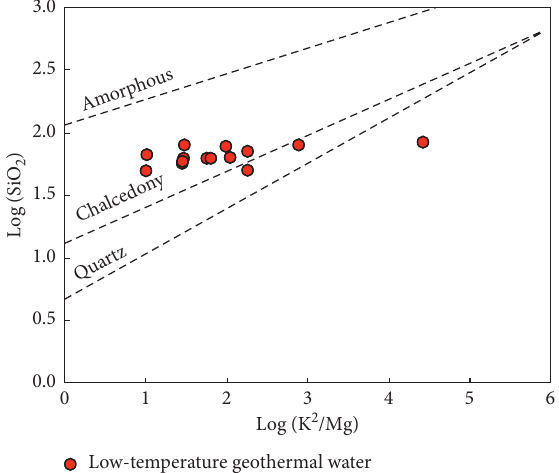
Figure 7: Cross-plot of log (K 2 /Mg) vs. log (SiO 2 ), unit: mg/L [42]. The lines are drawn using log (SiO 2 ) � 4.52 − (731/( t ° C+ 273.15)) for amorphous silica, log (SiO 2 ) � 4.69 − (1032/( t ° C+273.15)) for chalcedony, and log (SiO 2 ) � 5.19 − (1309/( t ° C +273.15)) for quartz from [43] and log (K 2 /Mg) � 14 − (4410/( t ° C+273.15)) from (96 ° C) at point “c” and Quartz solubility line at the point “d.” The horizontal axis of point “d” (151 ° C) suggested the reservoir temperature when no steam separated before